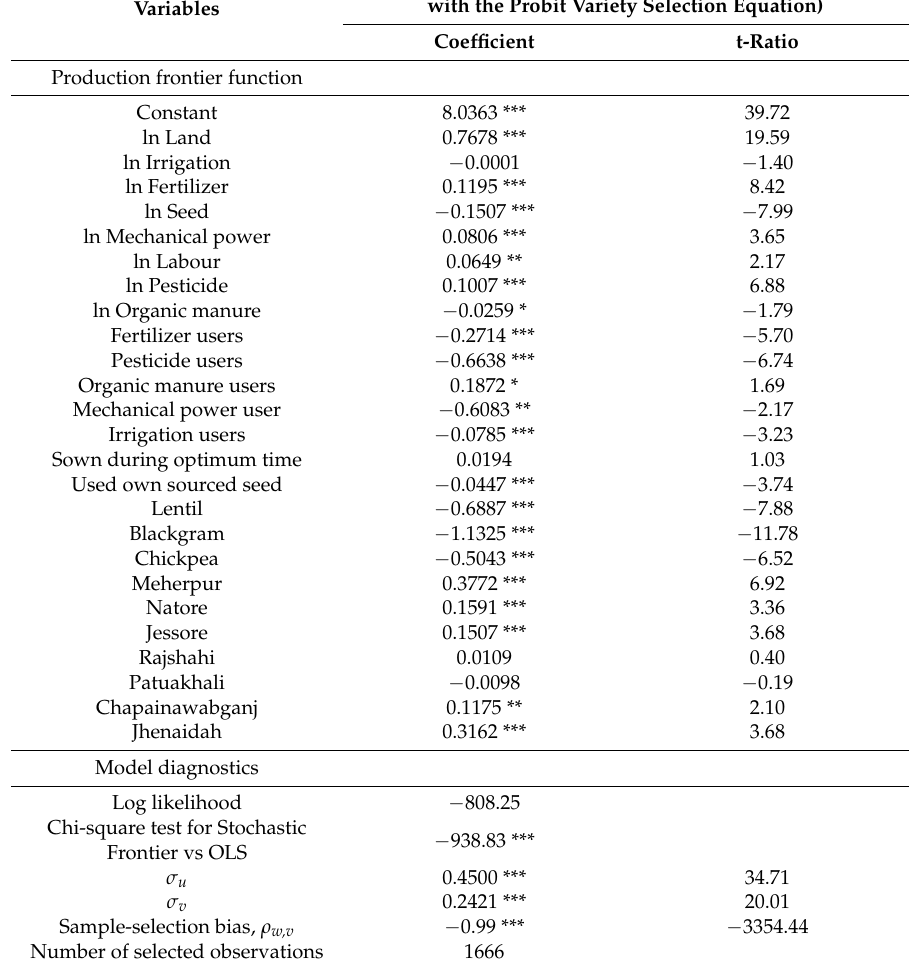
Table 6. Parameter estimates of the stochastic production frontier model for improved pulses corrected for sample-selection